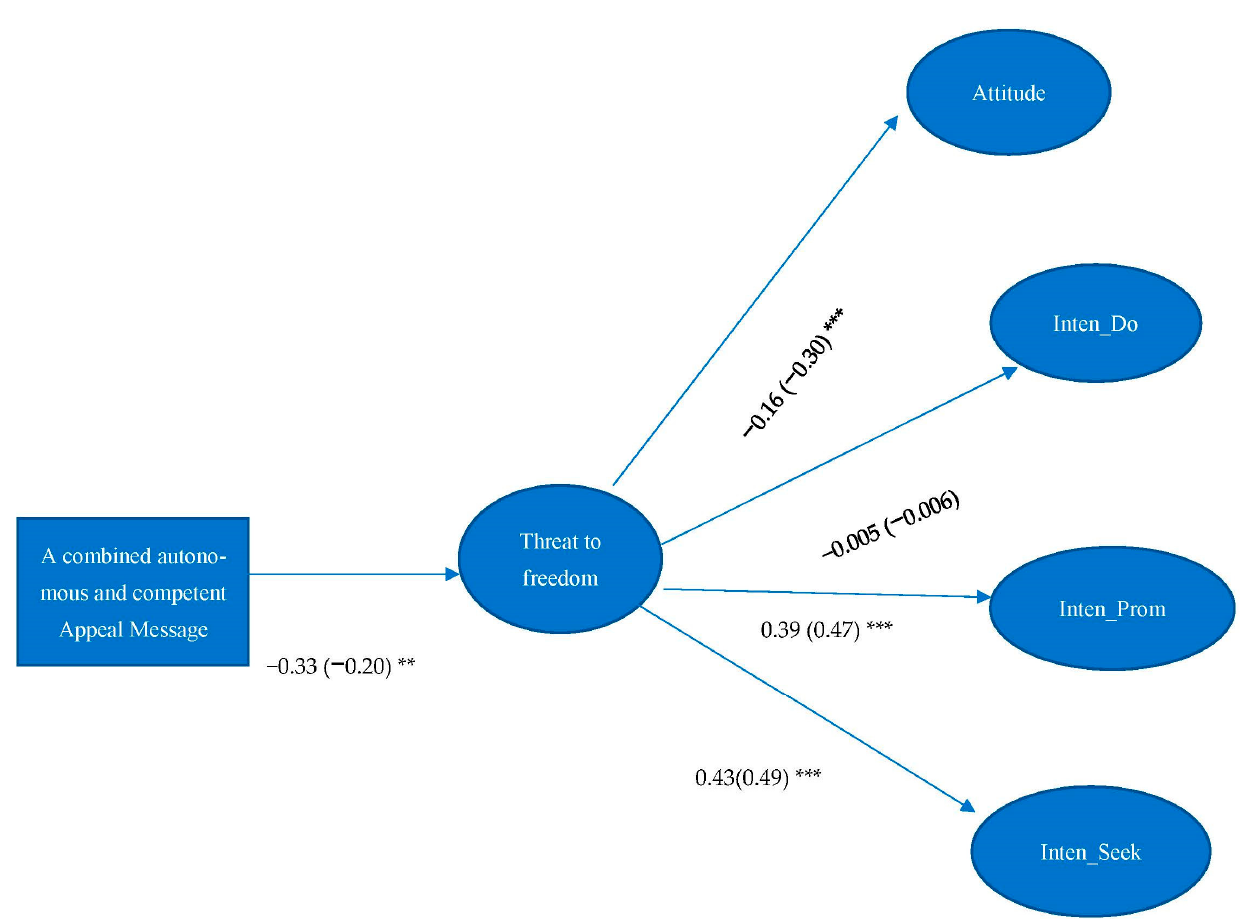
Figure 3. Unstandardized estimates are listed, followed by standardized estimates in